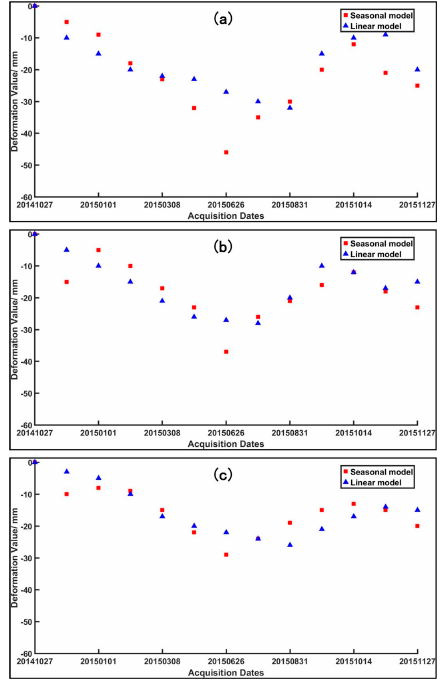
Figure 9. Locations of typical feature points A, B, C. ( a ) Deformation map over period of 27 October 2014 to 27 November 2015 in SAR coordinate system. ( b ), ( c ), ( d ) Locations of Point A, C (Levelling point K4) and B in Google Maps, respectively.